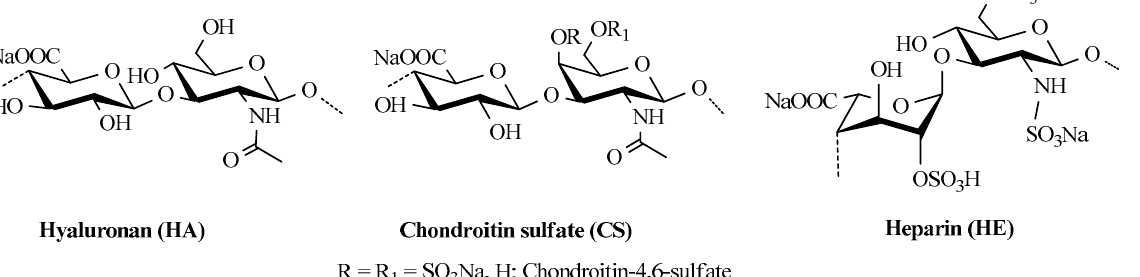
Figure 2. Chemical structures of GAGs used for the preparation of cryogels.